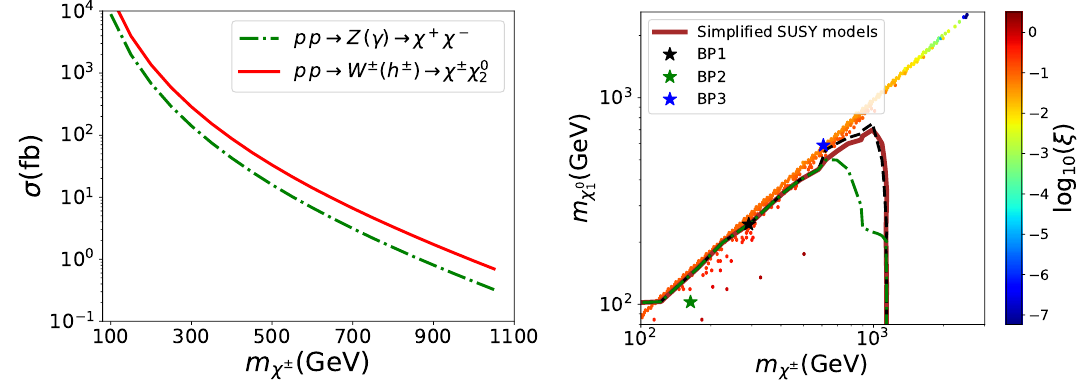
Figure 9 . (Left) Production cross-section of (cid:31) + (cid:31) (cid:0) , (cid:31) (cid:6) (cid:31) 0 m m = 20 GeV. (Right) Simpli(cid:12)ed SUSY model, BPs, and the scan discussed in section 3. (cid:31) 0 2 (cid:0) (cid:31) 0 1 Also, we show the black dashed line and the green dashed-doted line which correspond to the recasting of the ATLAS data for scenarios as BP1 and BP2. The ATLAS limit is based on 36 : 1 fb (cid:0) 1 of p s = 13 TeV proton-proton collisions at the LHC with two or three lepton (cid:12)nal state [18].